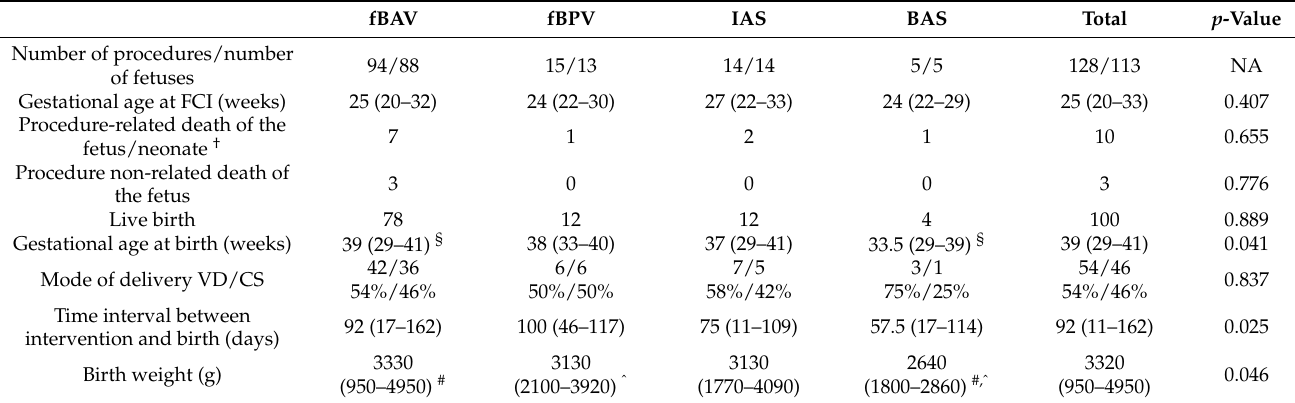
Table 3. Pregnancy outcomes according to the type of fetal cardiac